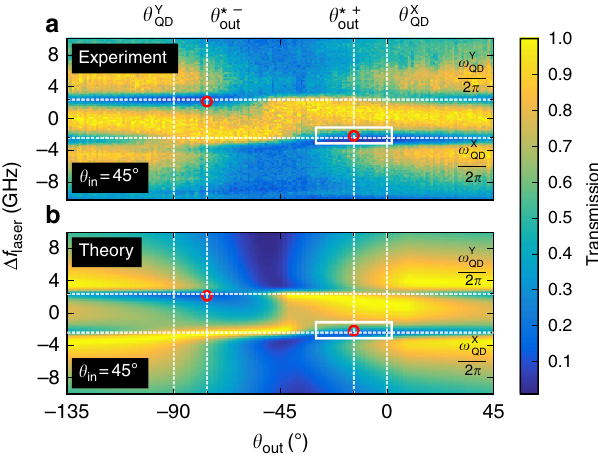
Figure 2 | Coherent probing of the QD cavity system. Experimental ( a ) and theoretical ( b ) false colour plot of the columnwise normalized optical transmission as a function of the laser detuning D f Laser and the polarization y out ( y in ¼ 45 (cid:2) ). The fine-split QD transition frequencies are at 2 : 4GHz and f Y 2 : 4GHz. The red circles indicate the special f X QD ¼ (cid:5) QD ¼ polarization conditions; the white square indicates the area explored in Fig.